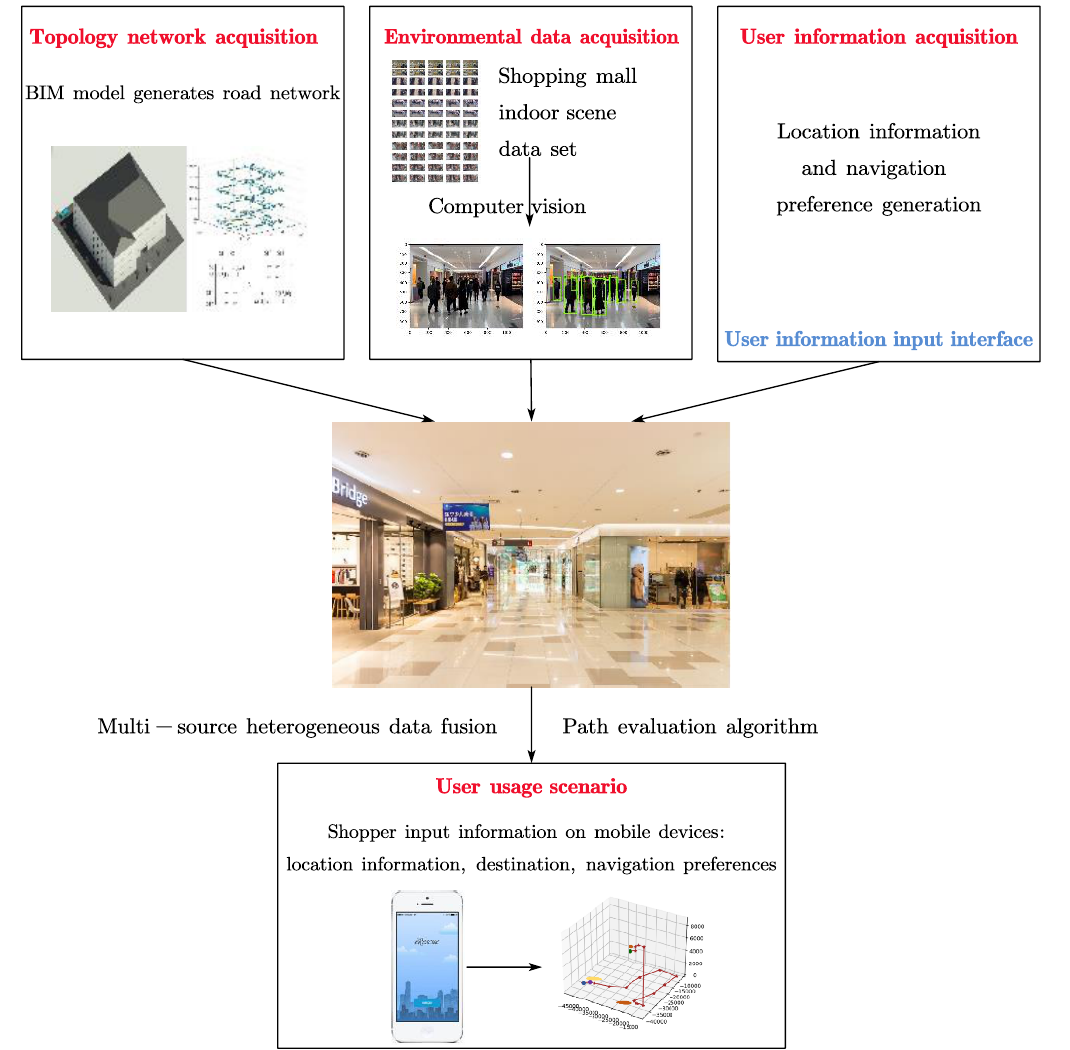
Figure 18. Shopping mall indoor navigation system.